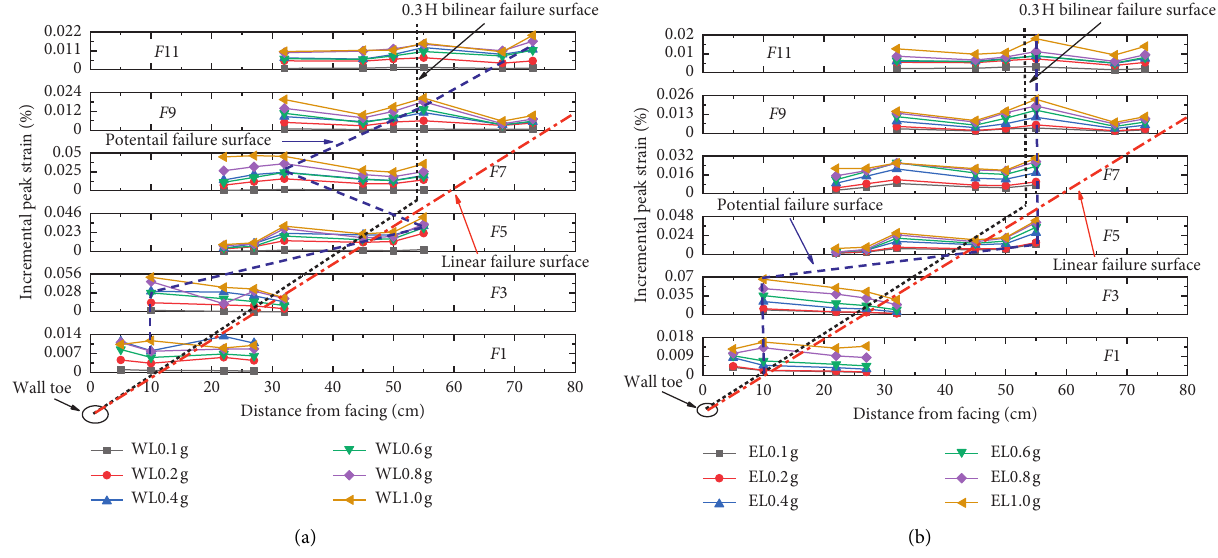
Figure 16: Distributions of the measured peak strain (scale factor: 1/4): (a) WL and (b) EL.